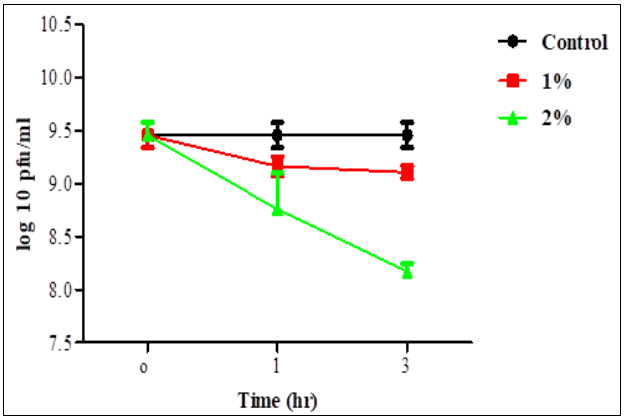
Figure 6. STEC P4 stability in 1 and 2% bile salt. LSD value at 0.05:0.296.